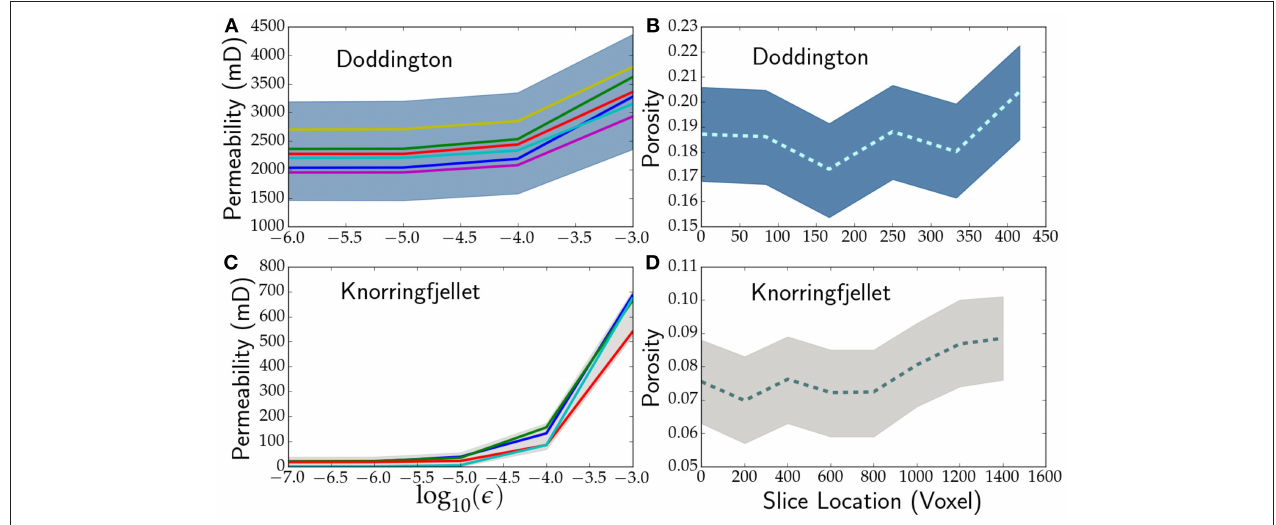
FIGURE 3 | (A) Plot of calculated permeability as a function of the residual from permeability simulations in Doddington Sandstone. (B) Variation of porosity measured within subvolumes of a sample of Doddington. (C,D) Same as in panels (A,B) respectively, from Knorringfjellet. The shaded region indicates the maximum and minimum values obtained from each subvolume.